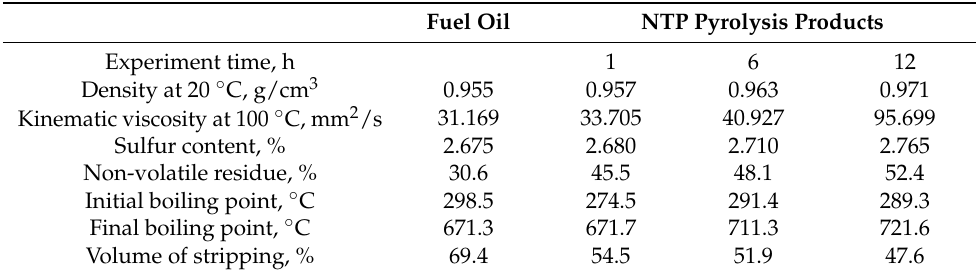
Table 3. Characteristics of fuel oil and NTP products—fuel oil pyrolysis at a voltage of 60 V and capacitance of capacitor of 41